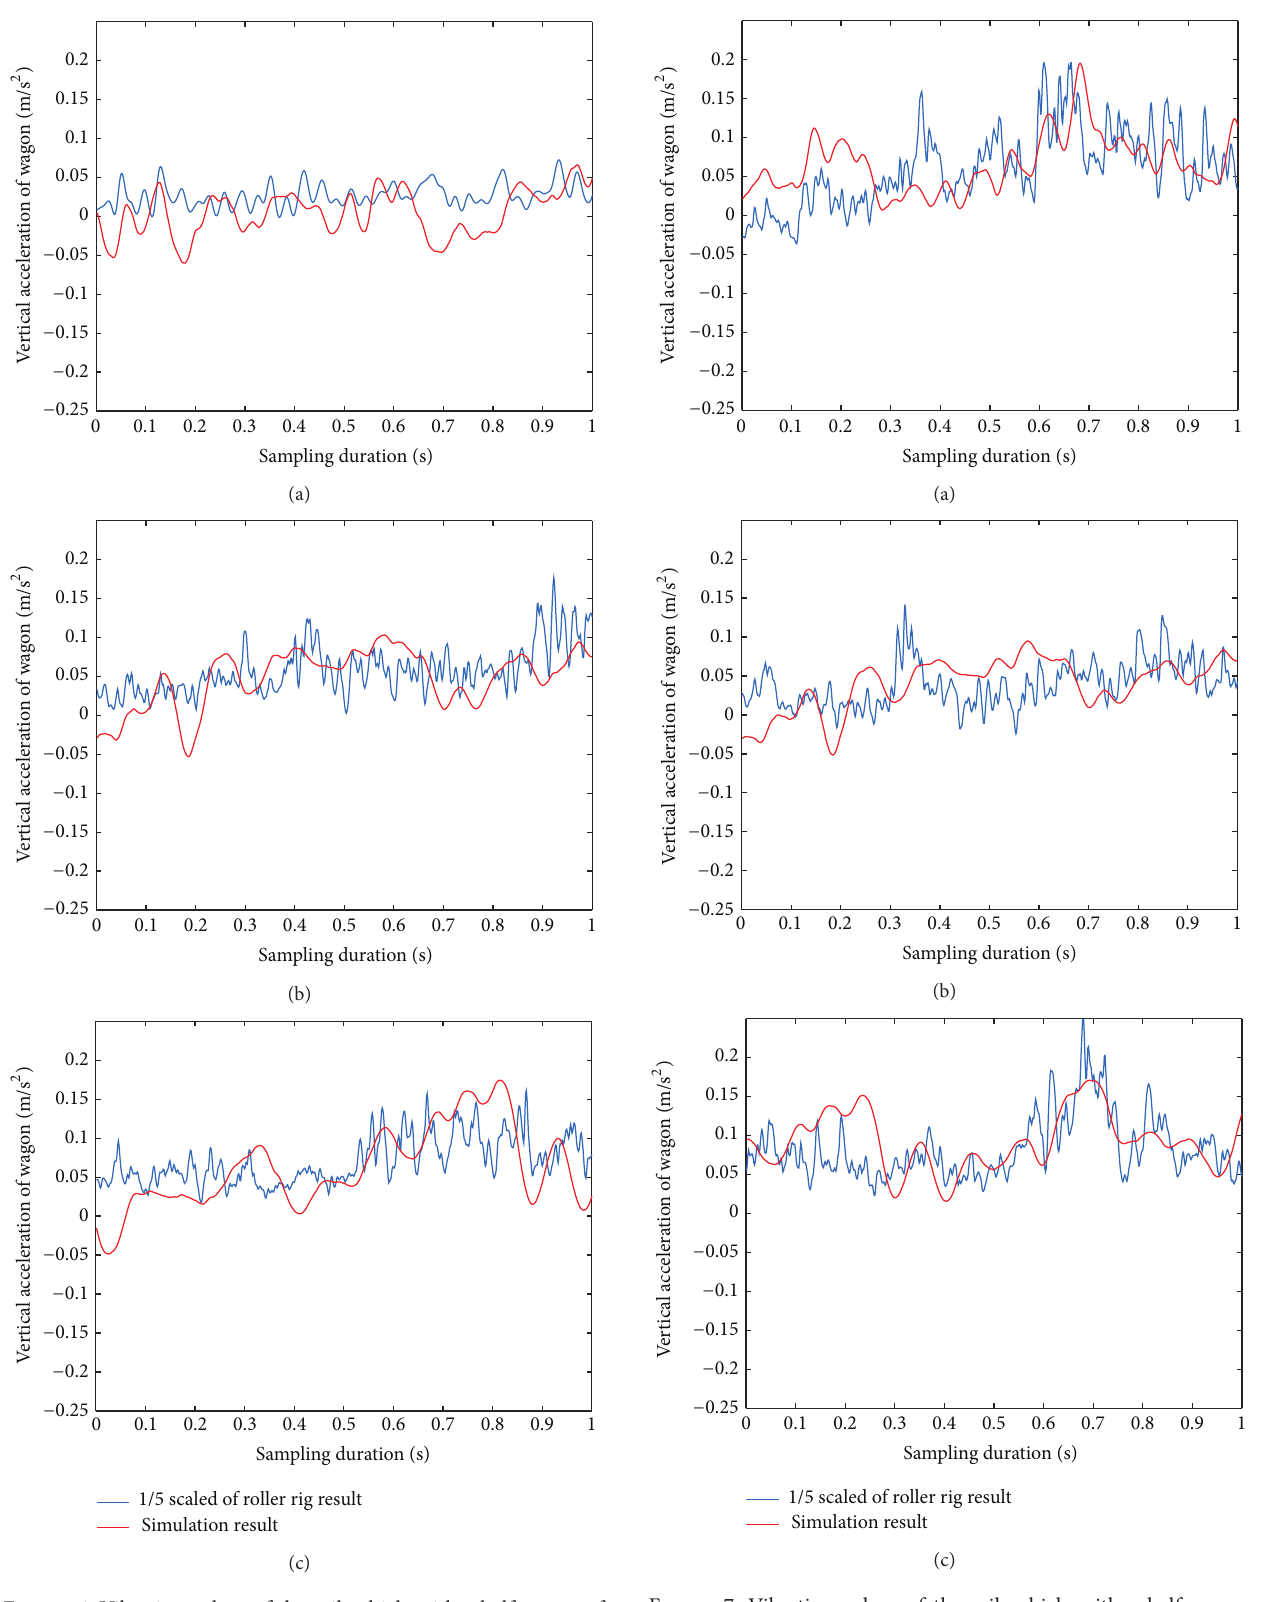
Figure 6: Vibration values of the rail vehicle with a half wagon of 20.75 tons moving in the horizontal plane on the bridge with an acceleration of 0.37 m/s 2 and with a velocity of (a) 150 km/h, (b) 200 km/h, and (c) 250 km/h.